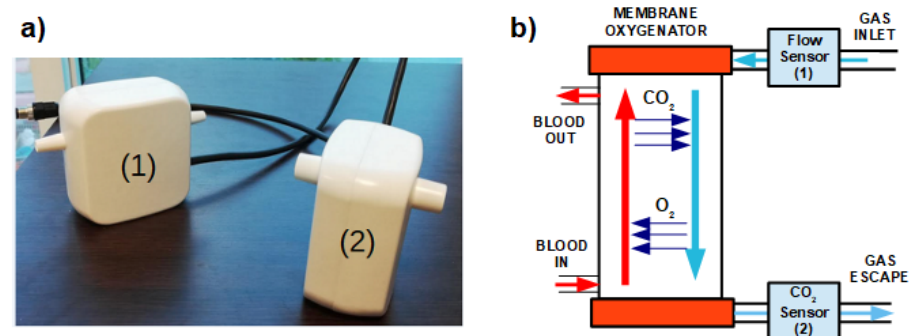
Figure 3. ( a ) Developed CO 2 sensing platform . (1) Flow measurement section; (2) CO 2 measurement section. ( b ) Schematic representation of flow sensor and CO 2 sensor on